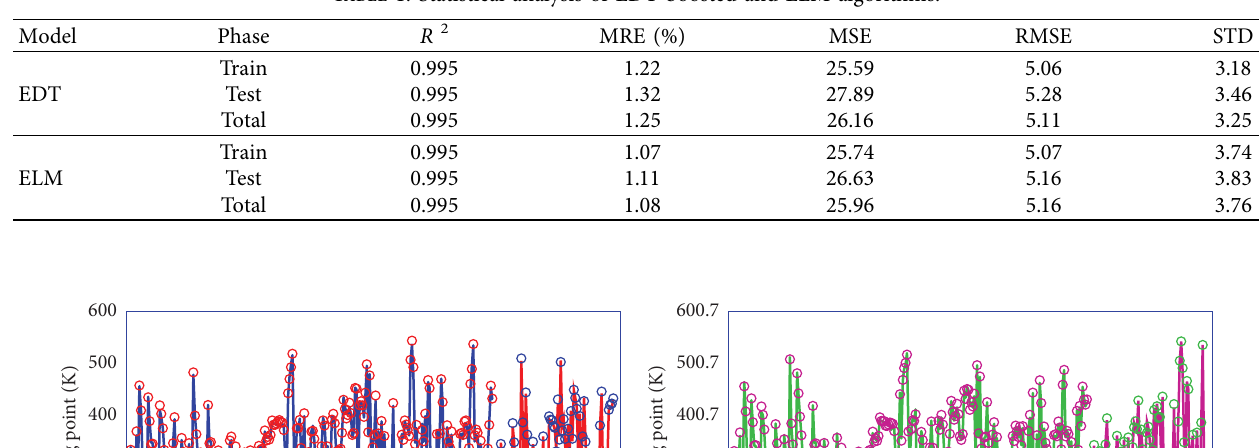
Table 1: Statistical analysis of EDT boosted and ELM algorithms.